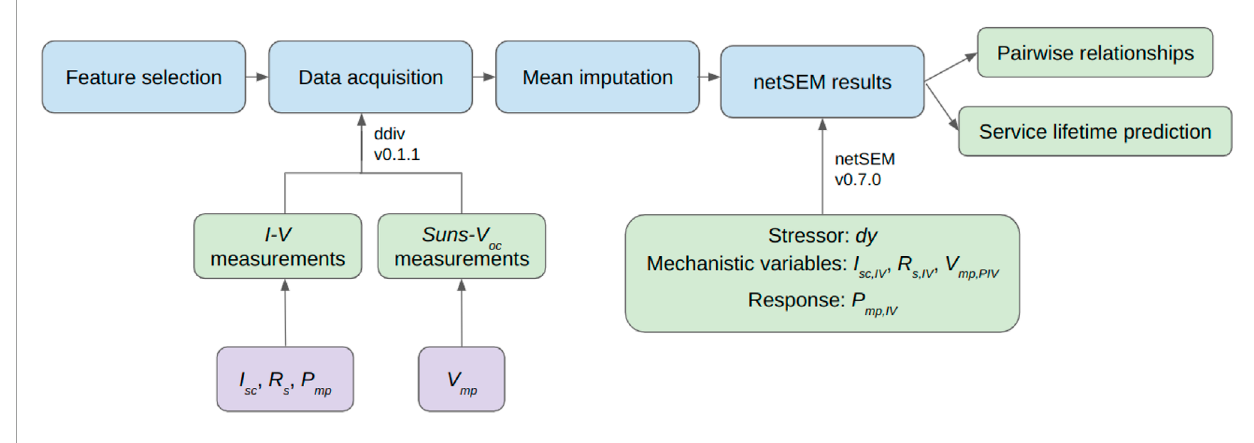
FIGURE 2 Flowchart showing the steps involved in obtaining netSEM